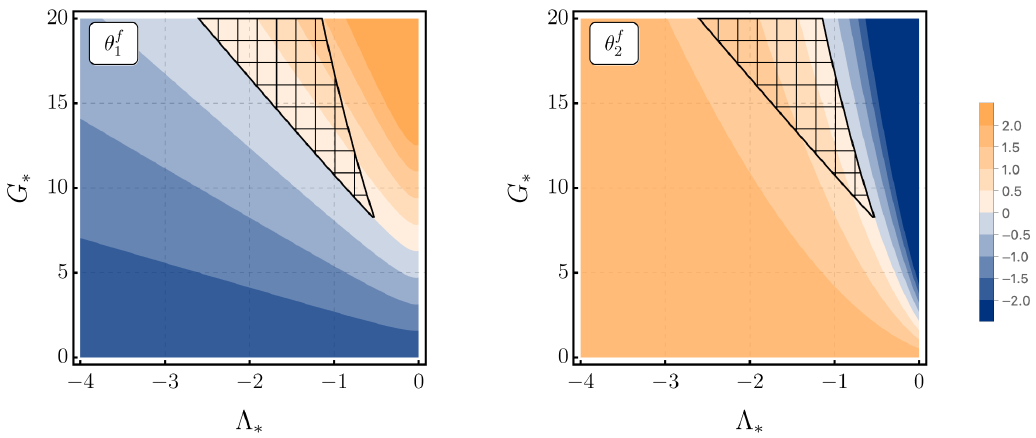
Figure 2 . We show the scaling exponents for the square of ALP-photon coupling and for the ALP mass squared at the free fixed point ( m 2 relevant couplings.